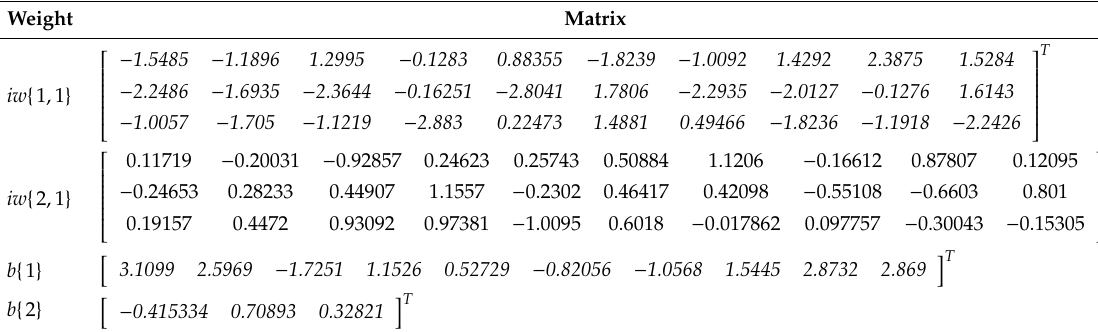
Figure 9. The training results of the 3-2-10-3 artificial neural network (ANN) model. Table 5. The weights of the established